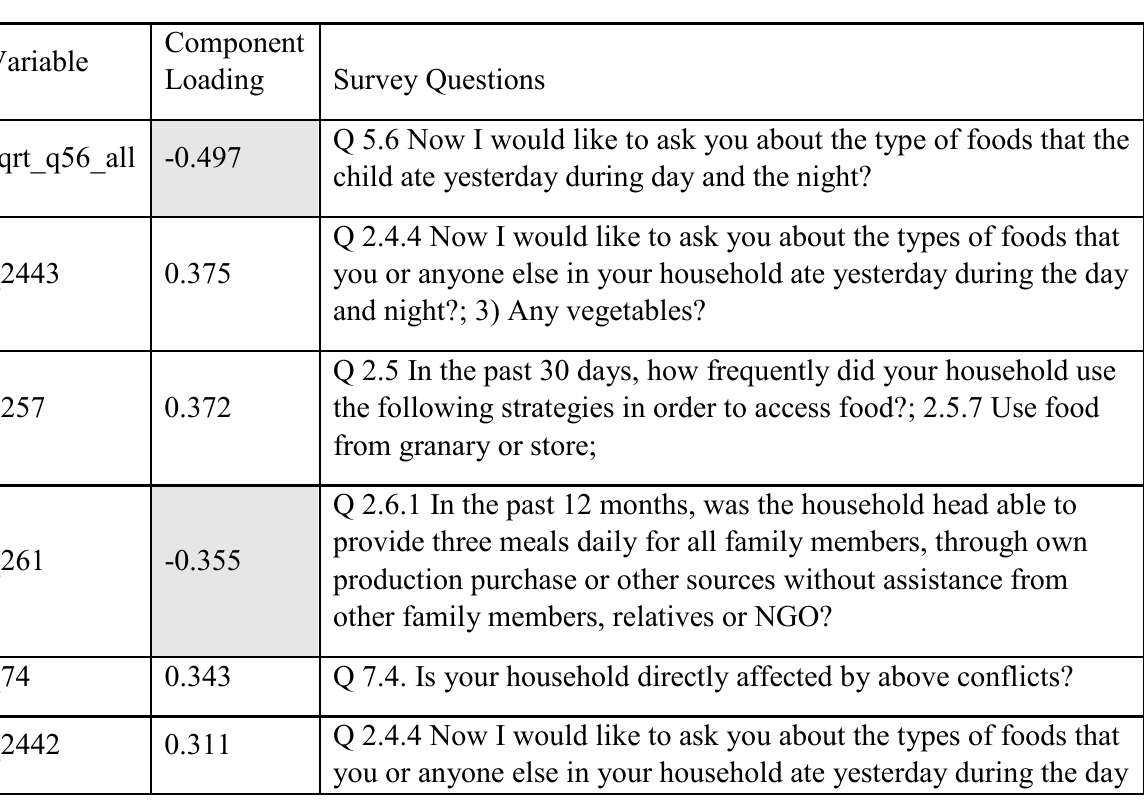
Table 1.10: Variables defining Absorptive Resilience